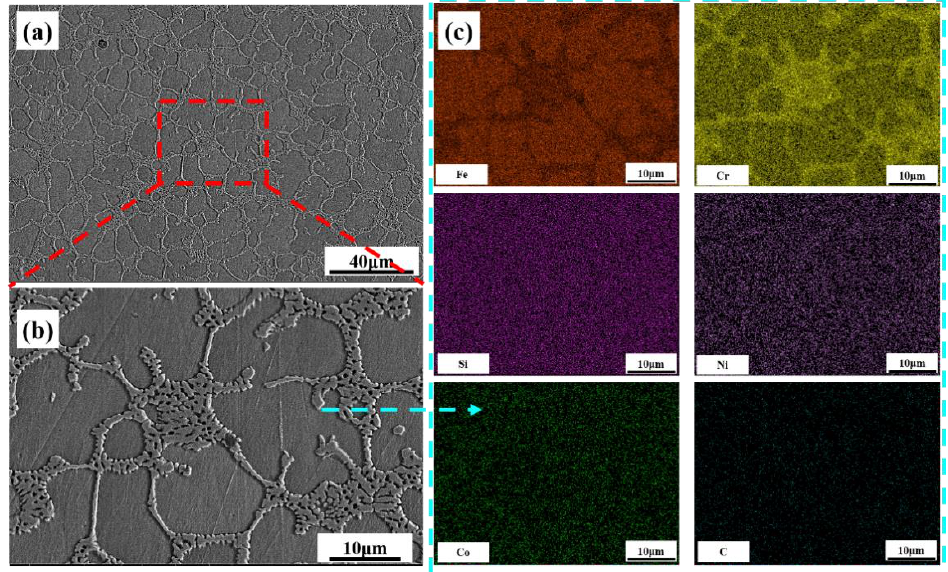
Figure 4. Microstructure of the FeCrSiNiCoC coatings at 50 °C: ( a ) low magnification and ( b ) high magnification SEM image; ( c ) EDS mapping.